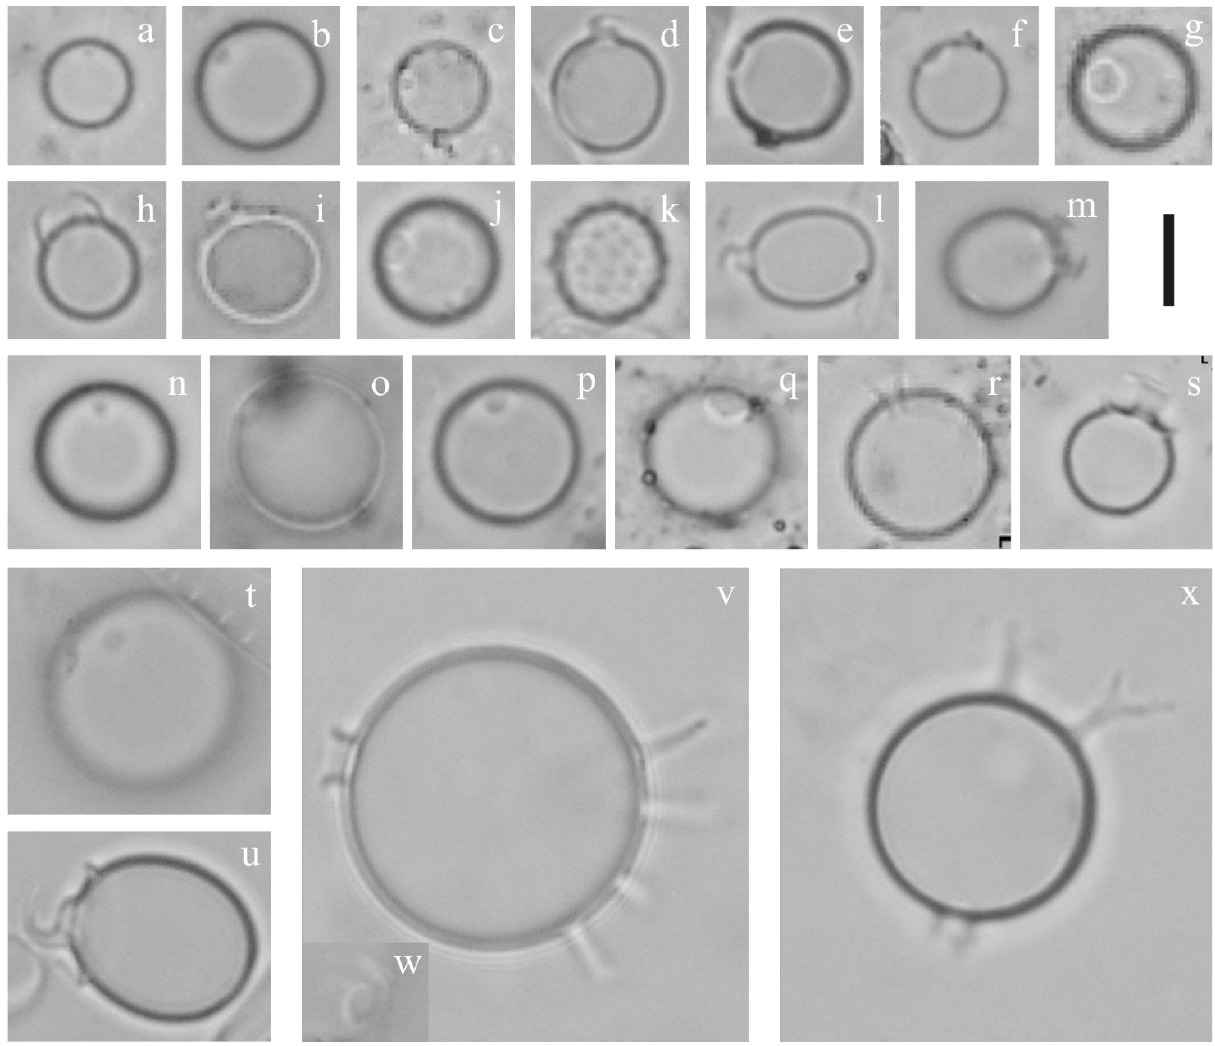
Figure 3. LM pictures of chrysophyte stomatocysts. a: Stomatocyst 1, Duff & Smol 1988 emend . Zeeb & Smol 1993a; b: Stomatocyst 120, Duff & Smol in Duff et al . 1992 emend . Zeeb & Smol 1993a; c: Stomatocyst 110, Zeeb et al . 1990; d and l: Stomatocyst 134, Duff & Smol in Duff et al . 1992; e: Stomatocyst #1, Bai & Chen (this article); f: Stomatocyst 52, Duff & Smol 1991 emend . Duff et al . 1995; g: Stomatocyst 183, Brown & Smol in Brown et al . 1994; h: Stomatocyst #2, Bai & Chen (this article); i: Stomatocyst #3, Bai & Chen (this article); j: Stomatocyst 334, Wilkinson & Smol 1998; k: Stomatocyst 86, Duff & Smol in Duff et al . 1995; m: Stomatocyst 136, Duff & Smol in Duff et al . 1992; n: Stomatocyst 9, Duff & Smol 1988 emend . Zeeb & Smol 1993a; o: Stomatocyst 19, Duff & Smol 1988; p: Stomatocyst 181, Brown & Smol in Brown et al . 1994; q: Stomatocyst 234, Duff et al . 1995; r: Stomatocyst 41, Pang & Wang 2017; s: Stomatocyst 187, Brown & Smol in Brown et al . 1994; t: Stomatocyst 42, Duff & Smol 1989; u: Stomatocyst 135, Duff & Smol in Duff et al . 1992; v: Stomatocyst 80, Hansen 2001; w: spiral ridge ornamentation on the base of the outer collar of Stomatocyst 80, Hansen 2001; x: Stomatocyst #4, Bai & Chen (this article). Scale bar = 5